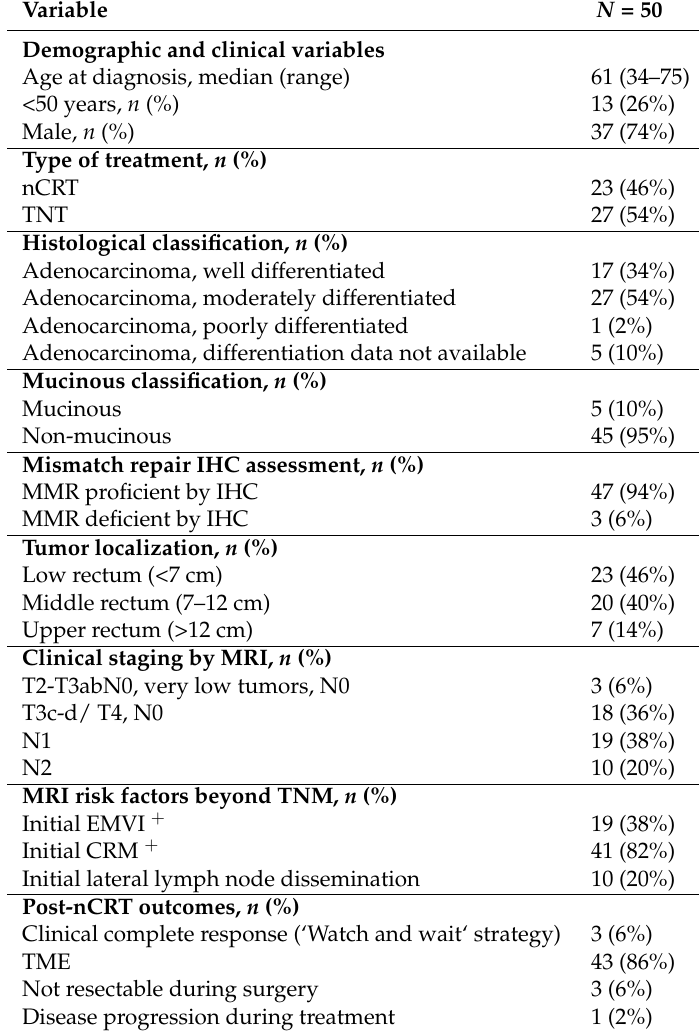
Table 1. A summary of clinical and pathological features of the LARC